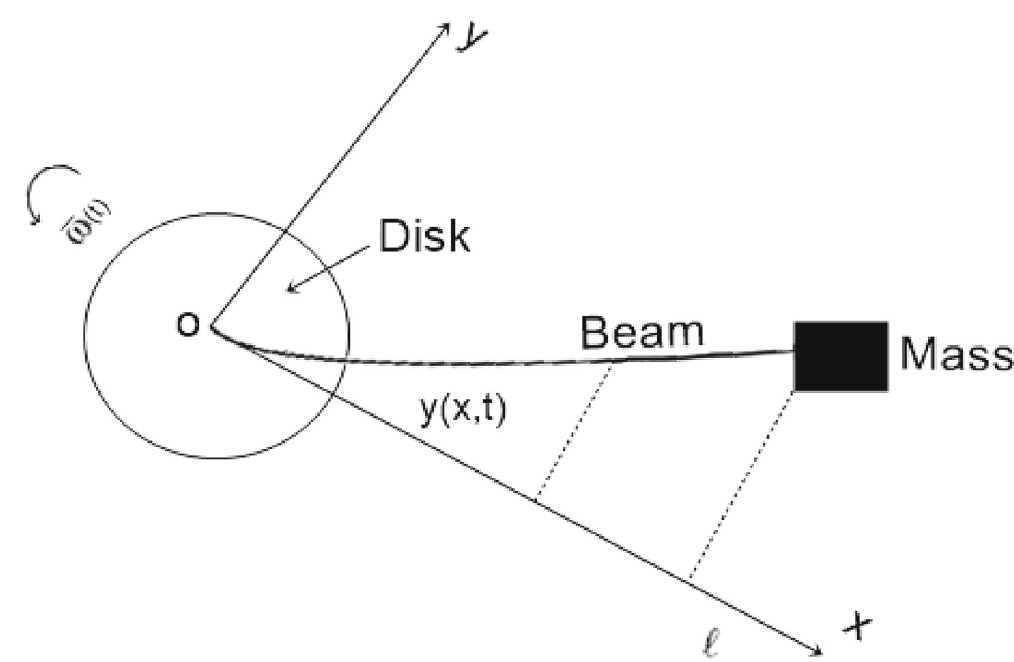
Fig. 1 Disk-beam-mass system (Chen et